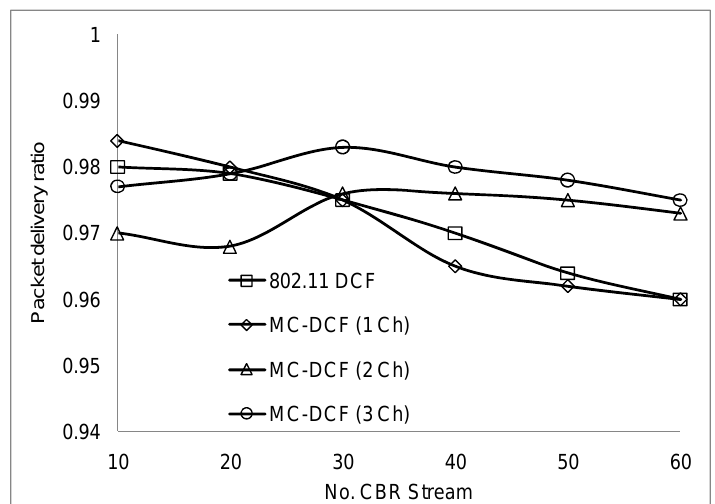
Figure 10. Delivery ratio impact on CBR stream.